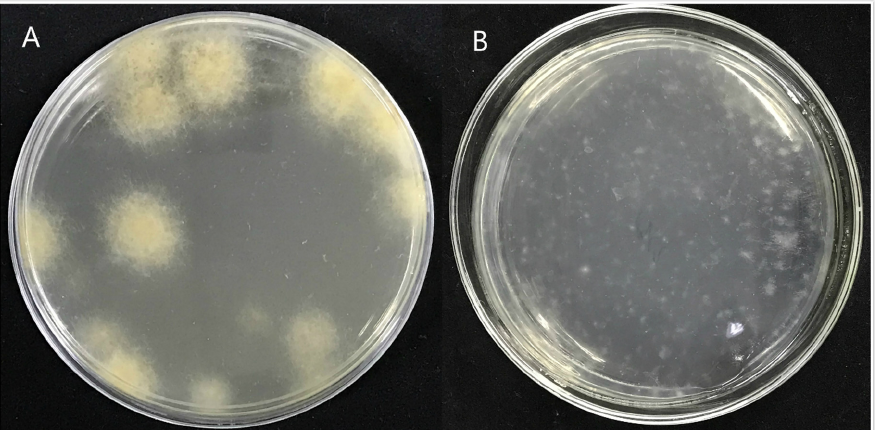
Figure 9. Colony diagram of transformant. Note: ( A ): Colony diagram of transformed strain Δ Ap Ctf1 β after 4 days of incubation at 25. ( B ): Colony diagram of transformed strain Δ Ap Ctf1 β after one day of incubation at 25.